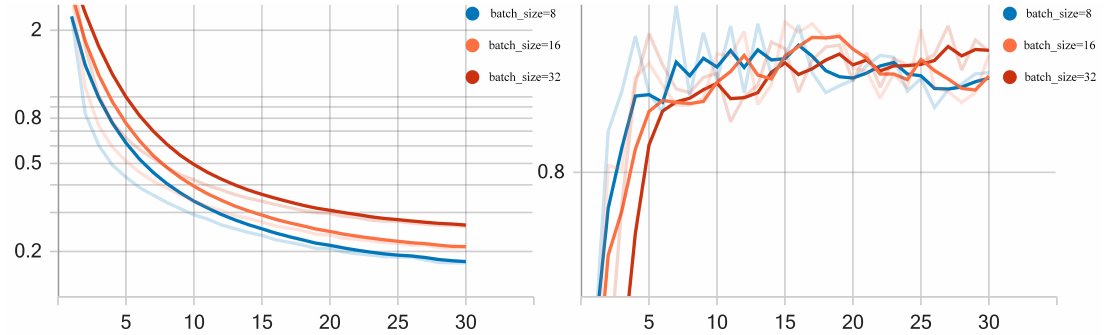
Figure 6. Convergence and Bleu-1 values of DFEN Model with different batch_size in UCM-caption dataset.